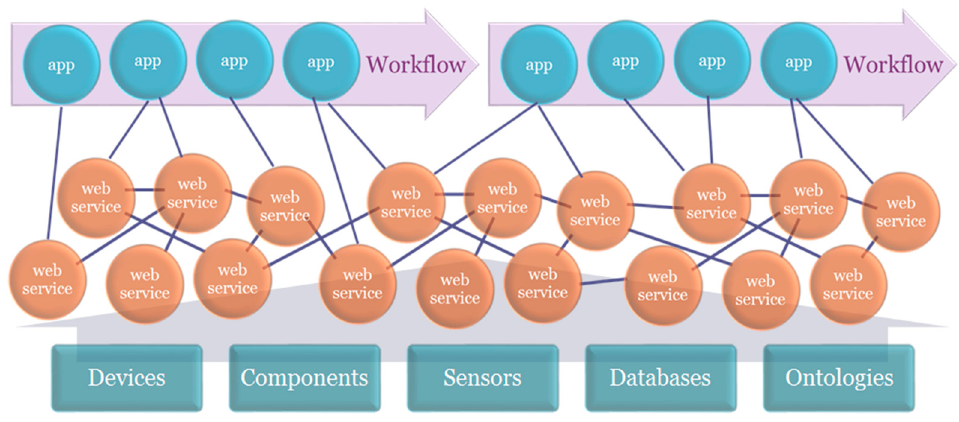
Figure 9. Interacting web services feeding into apps within application workflows.